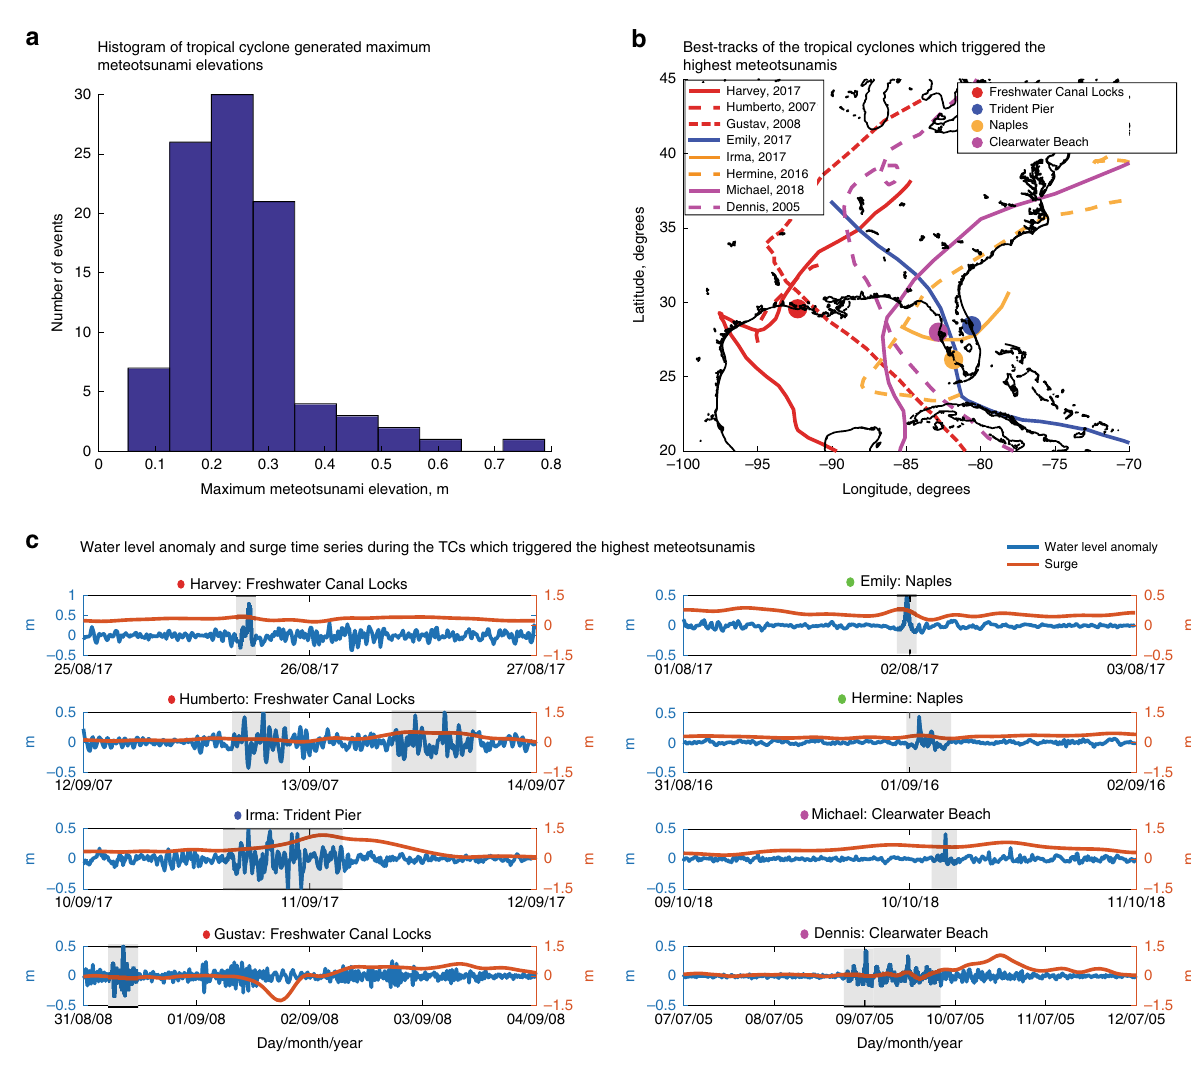
Fig. 1 Tropical cyclone-induced meteotsunamis. a Histogram of maximum meteotsunami elevations for the tropical cyclone (TC)-triggered meteotsunamis during the 1998 – 2018 Atlantic hurricane seasons. b Best-tracks of the TCs that created the eight maximum meteotsunami events. The red/ gold/blue/magenta lines represent best-tracks of the TCs that created the maximum meteotsunami elevations in Freshwater Canal Locks/Naples/Trident Pier/Clearwater Beach respectively. The locations of Freshwater Canal Locks/Naples/Trident Pier/Clearwater Beach tide gauges are indicated with red/ gold/blue/magenta dots, respectively. c Storm surge and water level anomaly (period < 5 h) time-series measured at Freshwater Canal Locks during Harvey (2017), Humberto (2007), and Gustav (2008); at Trident Pier during Irma (2017); at Naples during Hermine (2016) and Emily (2018), and at Clearwater Beach during Michael (2018) and Dennis (2005). The x -axis indicates the time in UTC, Day/Month/Year. Blue lines represent water level anomalies and correspond to the y -axis on the left; orange lines represent the lower frequency oscillations (tide + surge) and correspond to the y -axis on the right. Main meteotsunamis are indicated with gray